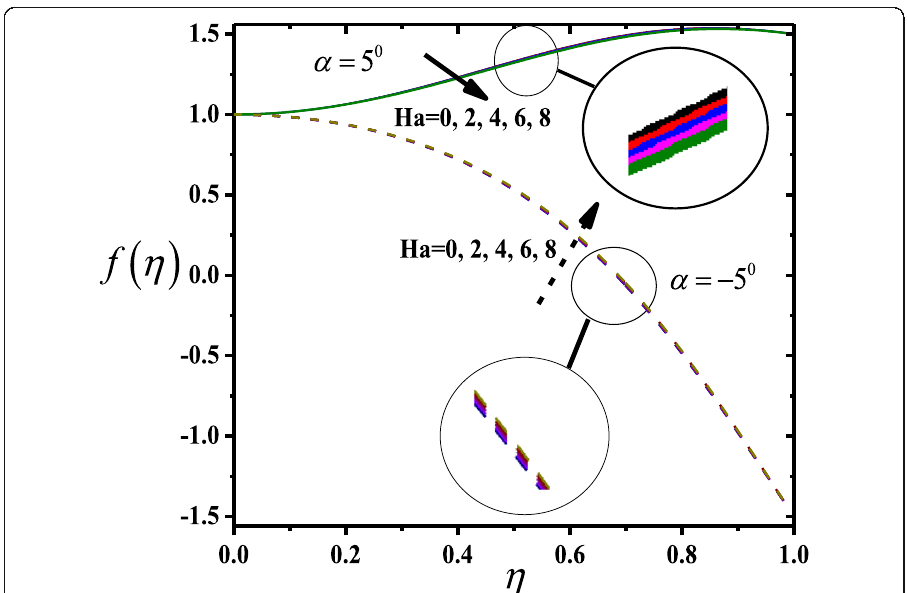
Fig. 2 Velocity vs. Ha in stretching divergent and shrinking convergent